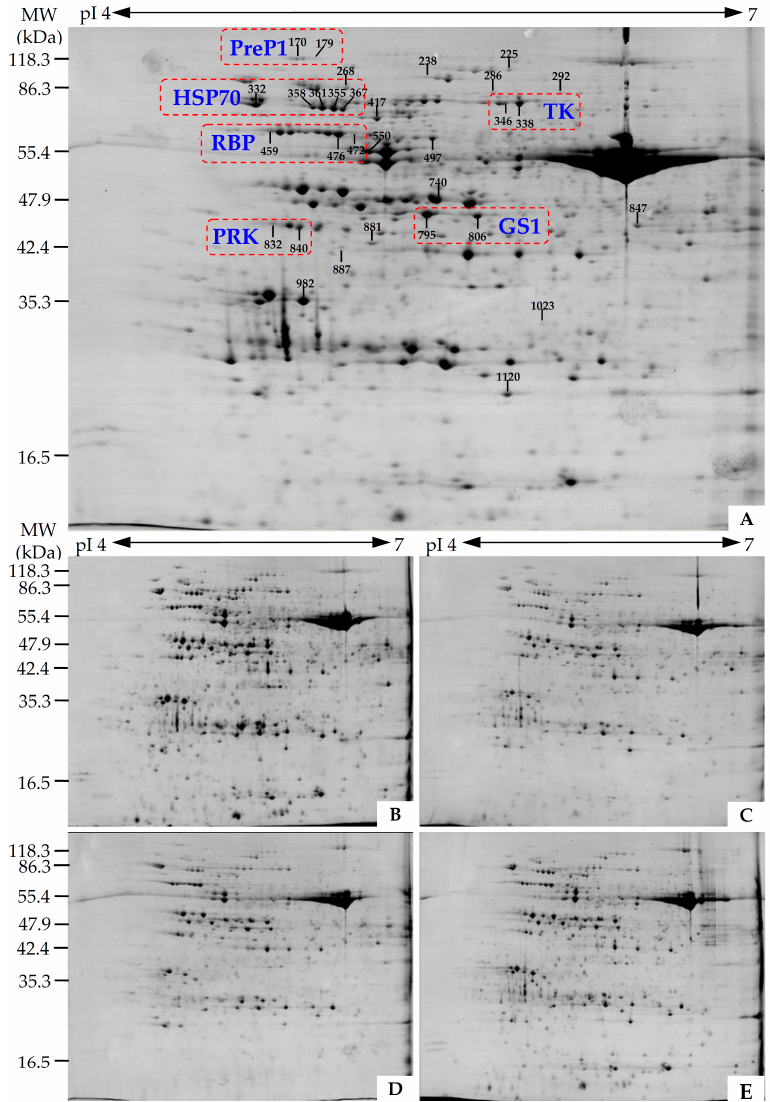
Figure 5. Representative 2-DE gel images of proteins extracted from various leaf regions at different development stages of Hosta “Gold Standard”. ( A ) Young leaf margin (YLM); ( B ) young leaf center (YLC); ( C ) mature leaf margin (MLM); ( D ) mature leaf center (MLC); ( E ) leaf under excess nitrogen fertilization (LENF). Proteins were separated on 24 cm immobilized pH gradient (IPG) strips (pH 4–7 linear gradient) using isoelectric focusing (IEF) in the first dimension, followed by 12.5% SDS-PAGE gels in the second dimension. The 2-DE gel was stained with Coomassie Brilliant Blue. Molecular weight ( M w) in kilodaltons (kDa) and pI of proteins are indicated on the left and top of the gel, respectively. A total of 31 differentially expressed proteins identified by MALDI TOF-TOF MS were marked with numbers on the gel, and the detailed information can be found in Table 1, Supplemental Figure S1, and Supplemental Tables S1 and S2. The protein spots of proteoforms in each group were enclosed in a red rectangle. GS1: Glutamine synthetase isoform GS1c; Hsp70: Heat shock protein 70; PreP1: Presequence protease 1; PRK: Phosphoribulokinase; RBP: RuBisCO large subunit-binding protein subunit; TK, transketolase.